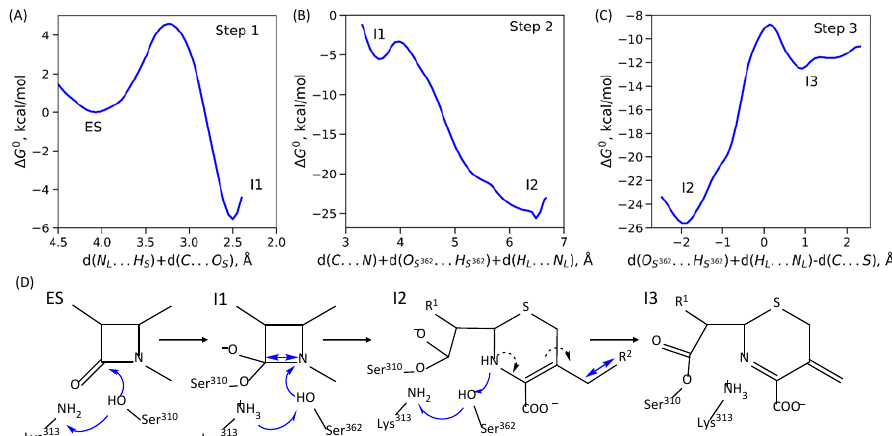
Figure 3. ( A – C ) Gibbs energy profiles of the elementary steps of acylation reaction in PBP2 FA19 – ceftriaxone complex; all energy values are relative to the ES. ( D ) Molecular mechanism of this reaction; plain blue arrows are reaction coordinates; dashed black arrows depict redistribution of electron pairs.